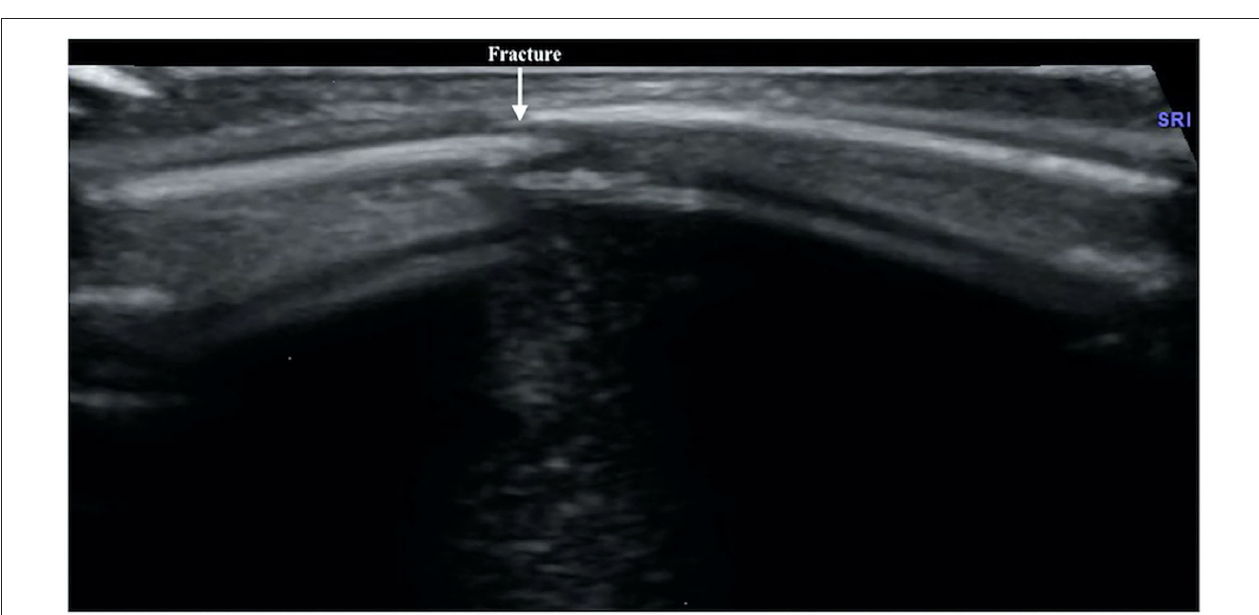
FIGURE 5 | Rib fracture. The infant was G 3 P 1 , with a gestational age of 30 + 1 weeks and a birth weight of 1,370g. The infant was born by Cesarean section due to placental abruption. After birth, the infant suffered from various diseases, such as respiratory distress syndrome, pneumonia, atelectasis, and calcium and phosphorus metabolism disorder, which was diagnosed as metabolic bone disease. Forty days after birth, an ultrasound examination found that the infant had a fracture in the fifth rib on the left side.